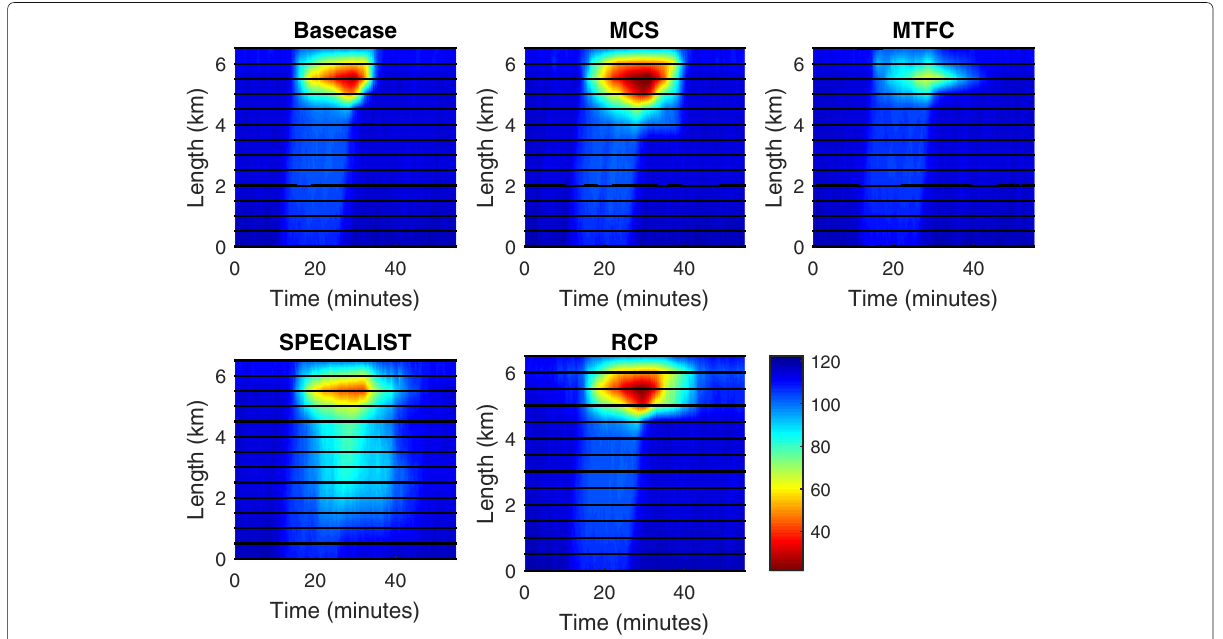
Fig. 4 Mean speed (km/h) at the detector stations for the base case and the VSL algorithms